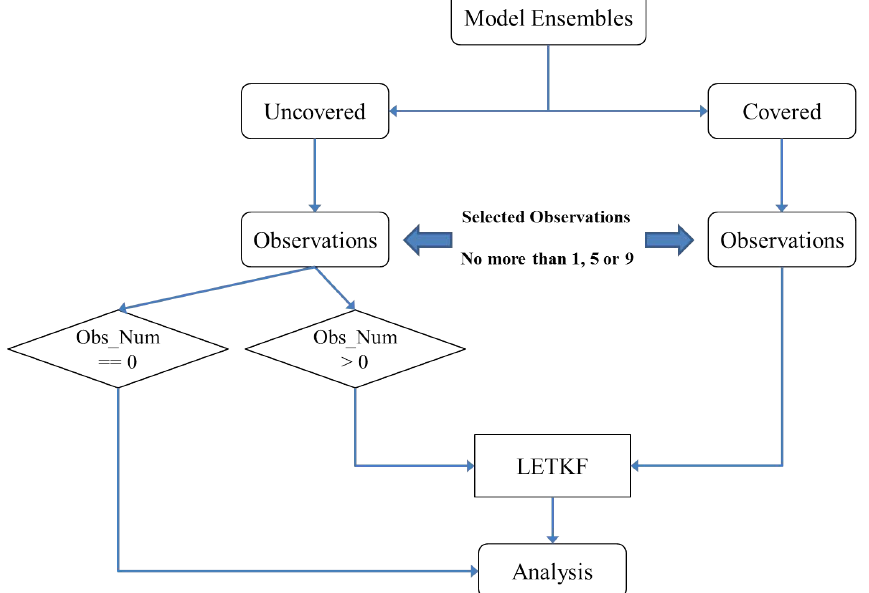
Fig. 2. Flow chart of data assimilation procedure for covered and uncovered grid cells, “Obs Num” is the number of